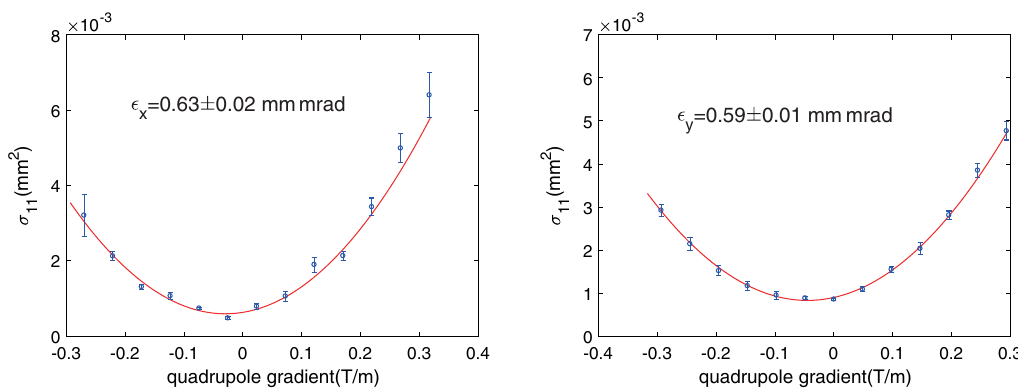
FIG. 9. A example of 500-pC bunch emittance